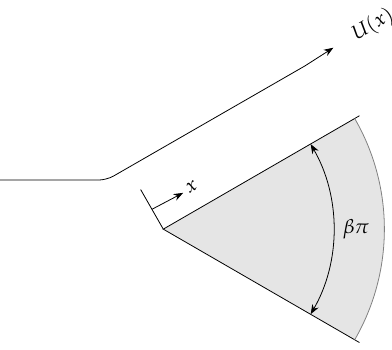
Figure 1. Boundary layer flow past a